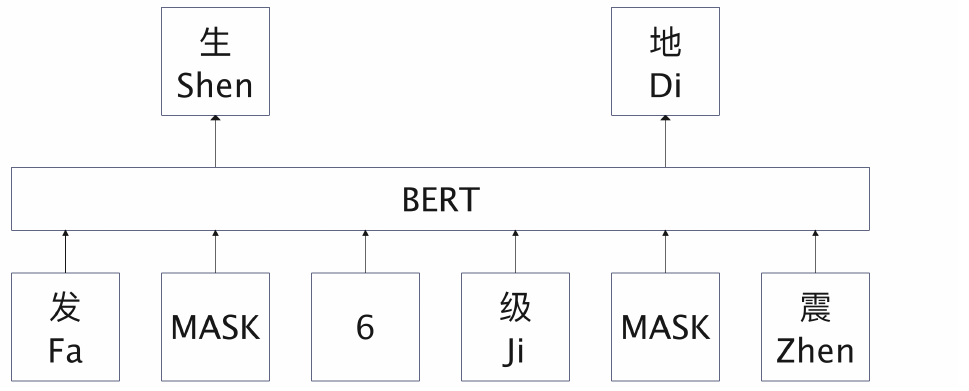
Figure 3. BERT model masking mechanism.